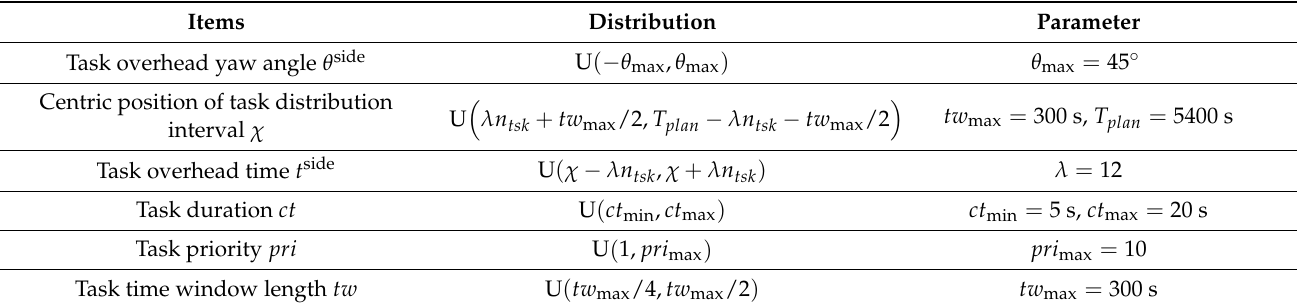
Table 4. The distribution of the test scenarios.